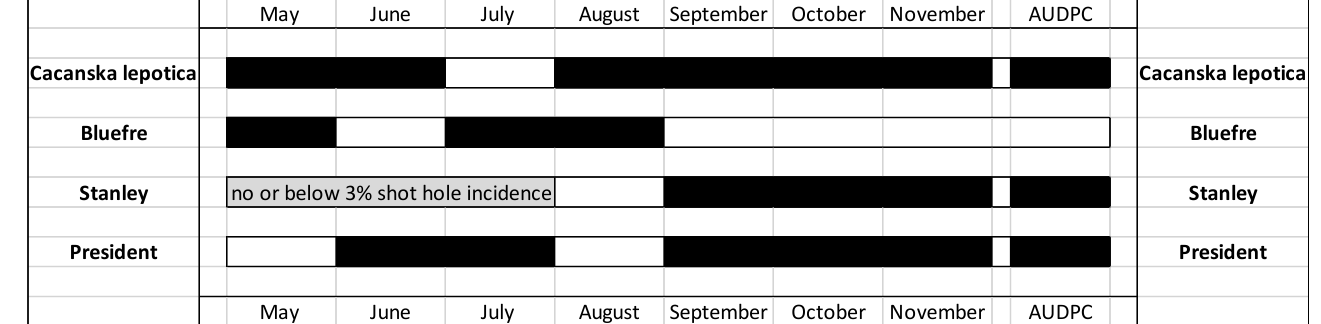
Figure 5. Time periods when high- vs. low-density training systems and cultivar combinations can reduce the disease development of shot hole disease incidence and area under the disease progress curve (AUDPC) in an integrated plum orchard at Debrecen-Pallag, Eastern Hungary. Low- and high-density training systems are 6 × 3 m and 4 × 1.5 m, respectively. Years were combined in the data analyses. Different color boxes represent significant differences at p = 0.05 level between low- and high-density training systems at a given month for the four plum cultivars. White color repre- sents ‘no significant differences’ and black color represents ‘significant differences at p = 0.05 level. Grey box represents no or below 3% shot hole incidence for cv. ‘Stanley’.